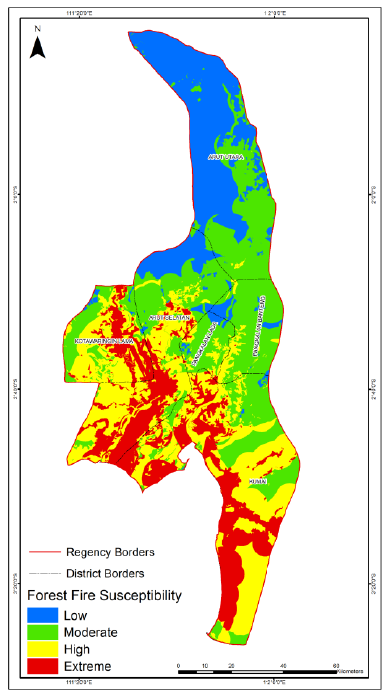
Figure 5. Forest and land fire susceptibility